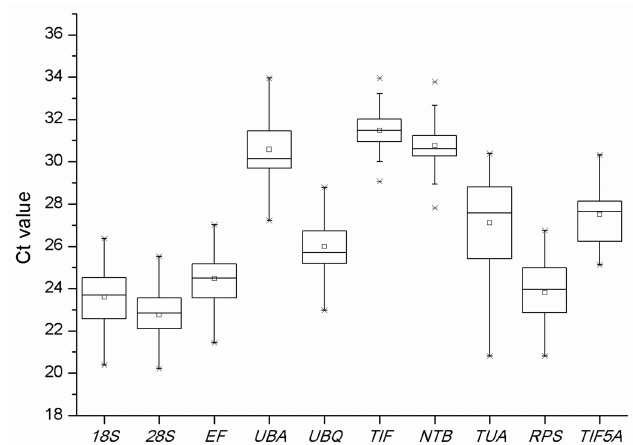
Figure 5. Distribution of the Cq-values of the ten candidate reference genes ( 18S, 28S, EF, UBA, UBQ, TIF, NTB, TUA, RPS , and TIF5A ) across all samples in qPCR